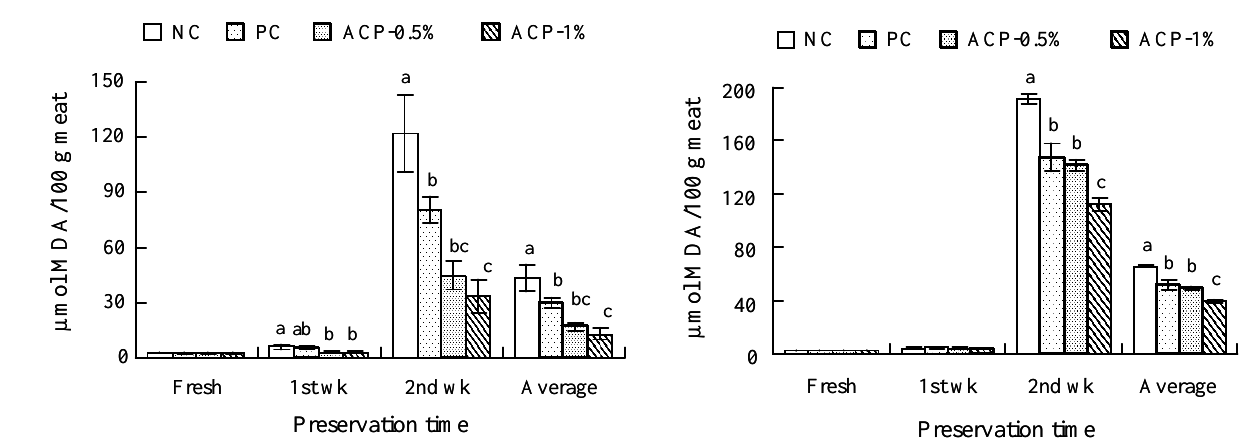
Figure 3. Effect of Alisma canaliculatum with probiotics on thiobarbituric acid reactive substance (TBARS) values of thigh meat (n = 15 for each treatment). TBARS values are expressed as micromoles of malondialdehyde (MDA) per 100 g of meat. Data are presented as the mean  SE. Bars within a time class not sharing a common letter are significantly different (p<0.05). NC